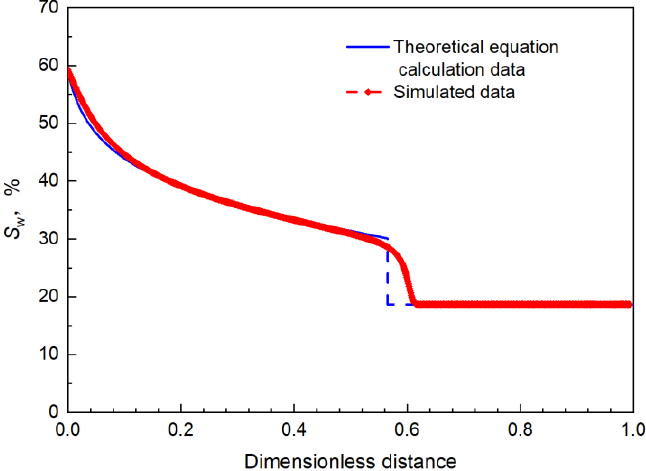
Figure 8. Comparison of water saturation distribution along the flow.